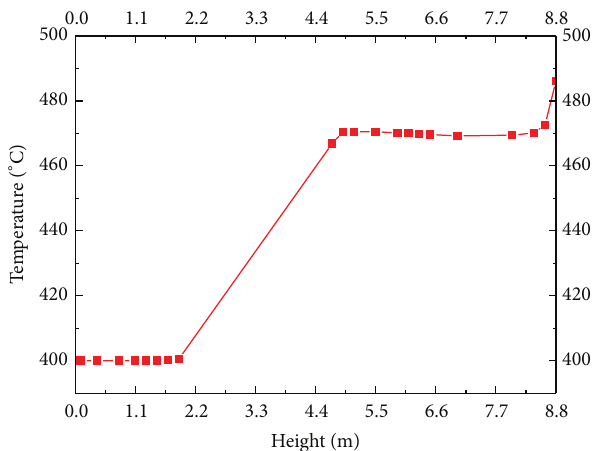
Figure 14: The axial coolant temperature distribution along the center of the